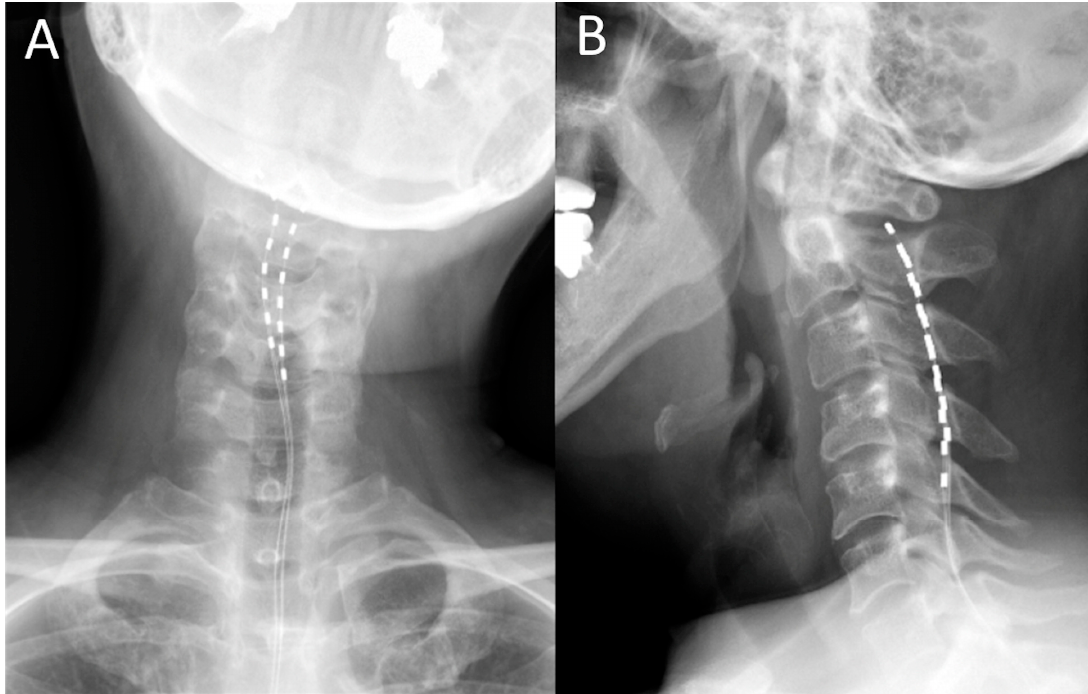
Figure 1. Postoperative cervical X-ray images following spinal cord stimulation. ( A ) Anteroposterior and ( B ) lateral view.